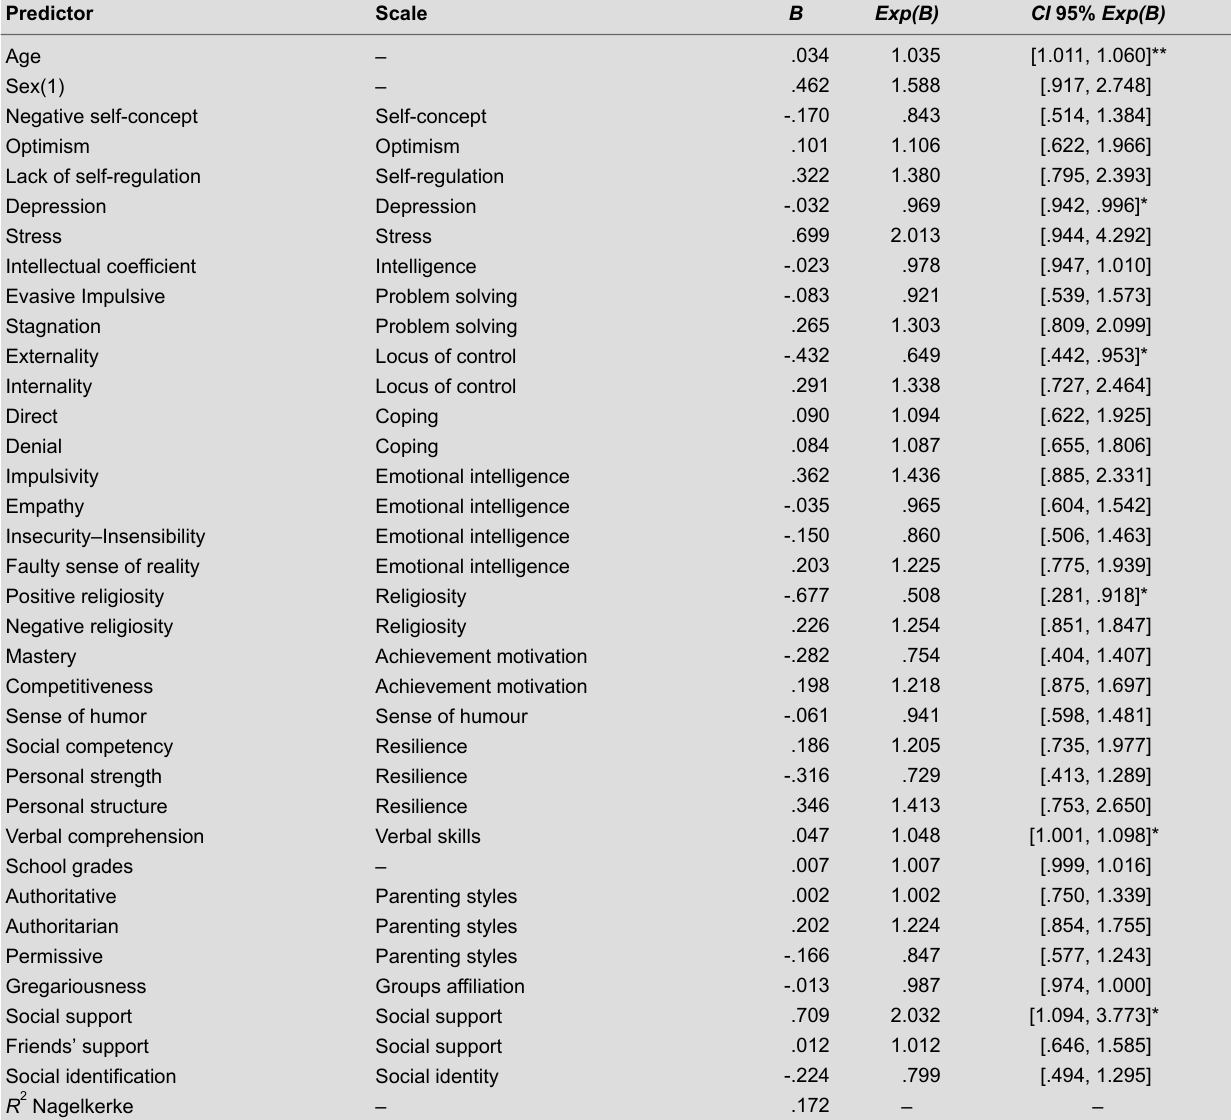
Predictors of Social Mobility